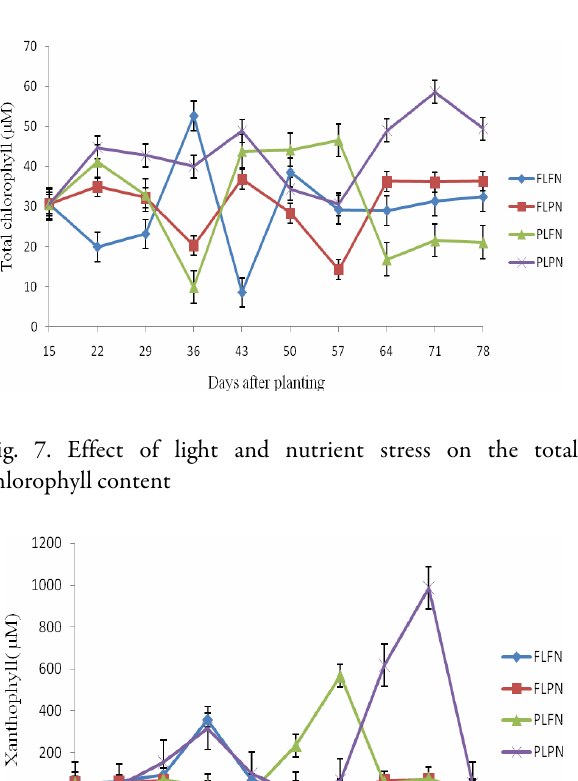
Fig. 6. Effect of light and nutrient stress on chrophyll b content